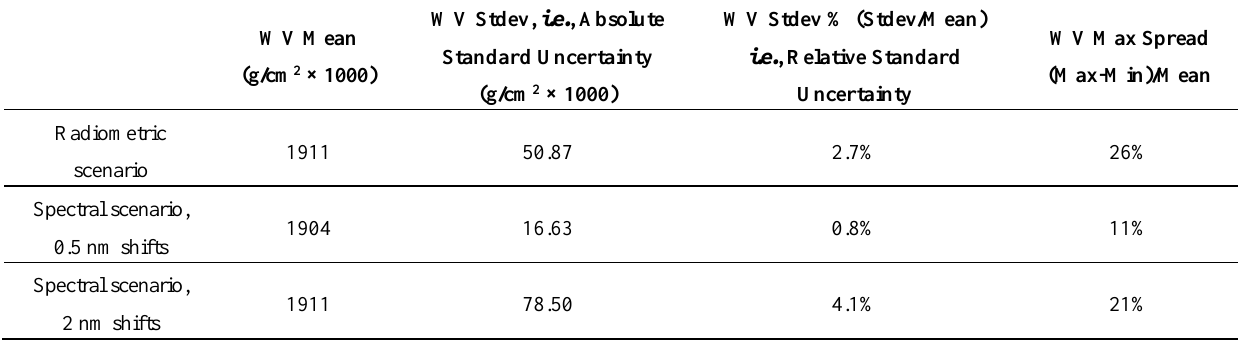
Table 2. Statistical description of the water vapour